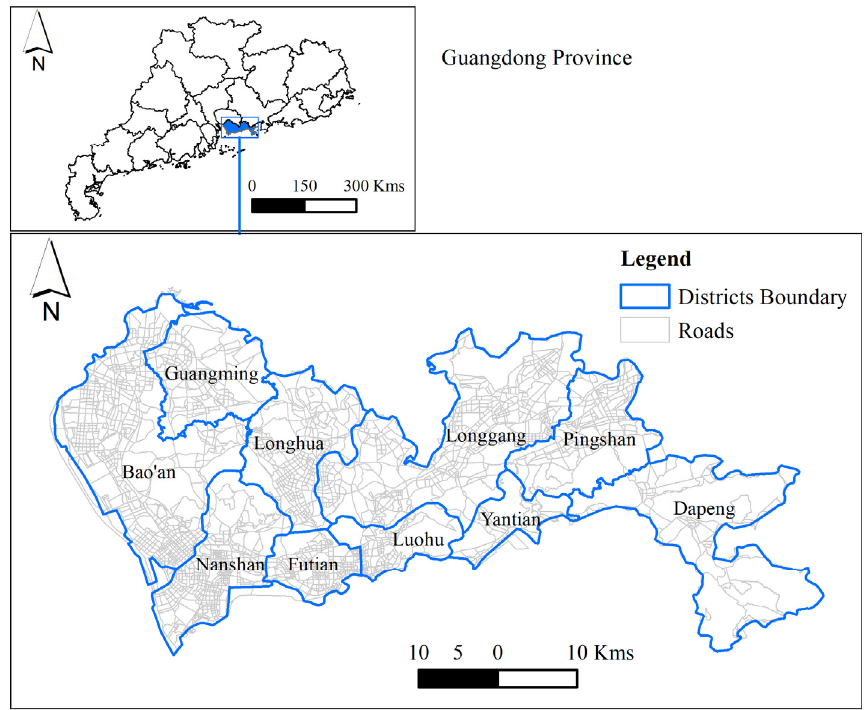
Figure 1. The study area map (the geographical background is obtained by vectorization from Shenzhen map provided by Shenzhen Municipal Bureau of planning and natural resources).